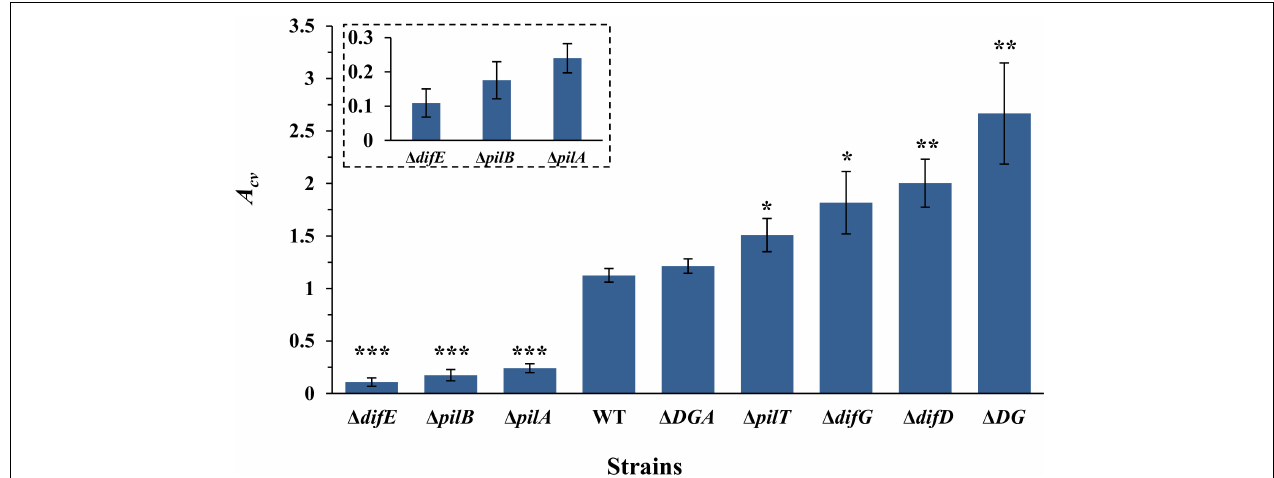
FIGURE 5 | SBF formation by M. xanthus T4P and EPS mutants. 100 µ l of a cell suspension with OD 600 at 0.4 was placed into a microwell. SBF was develop at 27 ◦ C with rotary shaking. Shown are the average A cv values with standard deviations from three independent experiments. Strains used were YZ603 ( (cid:49) difE ), DK10416 ( (cid:49) pilB ), YZ690 ( (cid:49) pilA ), DK1622 (WT), YZ645 ( (cid:49) difD (cid:49) difG (cid:49) pilA or (cid:49) DGA) , DK10409 ( (cid:49) pilT ), YZ604 ( (cid:49) difG ), YZ613 ( (cid:49) difD ), and YZ641 ( (cid:49) difD (cid:49) difG or (cid:49) DG ). Statistical difference from the WT is indicated by * P < 0.05, ** P < 0.01, or *** P < 0.0001. Shown in the insert are the data for YZ603, DK10416, and YZ690 at an enlarged